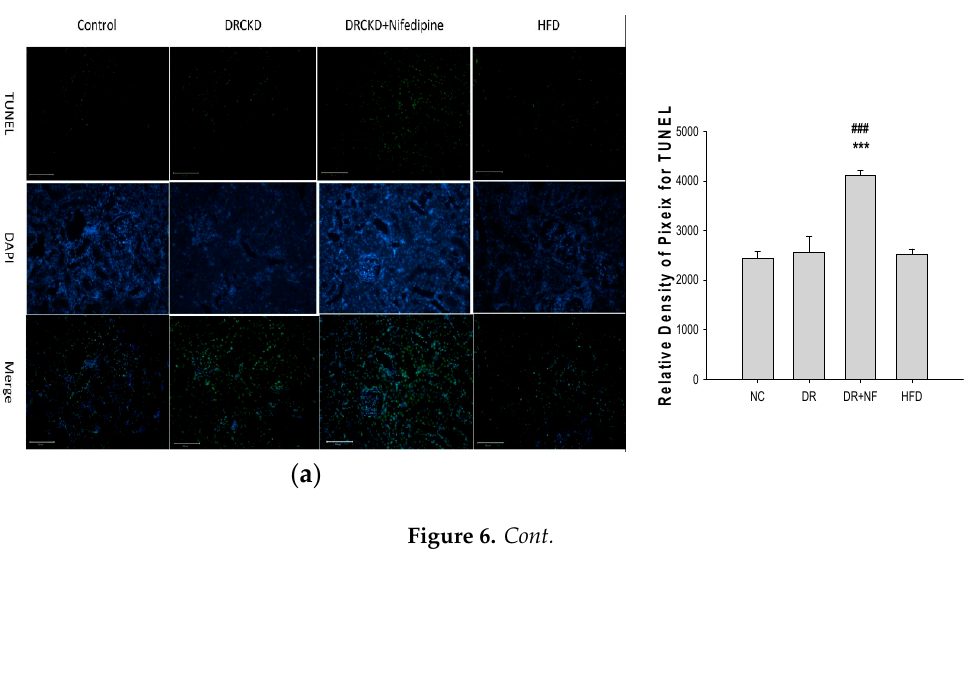
Figure 5. Cell apoptosis affected by nifedipine (NF) (30 µM). ( a ) Annexin V flow cytometric analysis. ( b ) Quantification of data of the Annexin V analysis. ( c ) Representative Western blots and quantitation of procaspase-3 and cleaved caspase-3 expressions. ( d ) Representative Western blots and quantitation of procaspase-7 and cleaved-caspase-7 expressions. β -actin was used as a constitutive protein control * P < 0.1, ** P < 0.05, *** P < 0.01 compared to 0 h ( n = 3). 2.6. NF also Enhanced Renal Apoptosis and Expression of Cleaved Caspase-3 in Rats with Experimentally Induced CKD Populations of apoptotic cells in DR-induced rat kidneys were significantly upregulated compared to those of the control and HFD groups, which were further enhanced by co-therapy with NF as evidenced by a TUNEL assay (Figure 6a). The Western blot analysis of cleaved caspase-3 further confirmed such an event (Figure 6b,c). Cleaved caspase-3 was respectively upregulated to 151.3%, 182.7%, and 176.5% in the DR, DR + NF, and HFD groups, compared to 110.6% in the control group (Figure 6c).